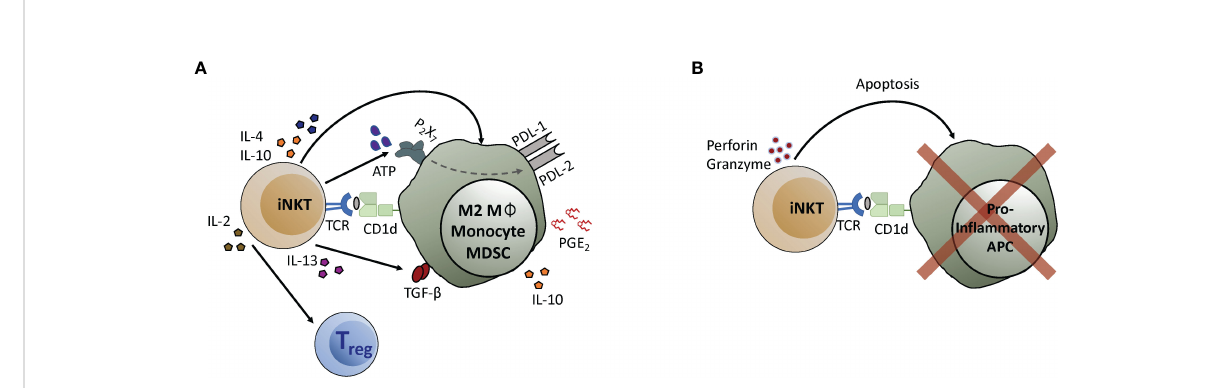
FIGURE 1 iNKT cell anti-in fl ammatory mechanisms. (A) iNKT cells interact with myeloid cell types to initiate the activation of regulatory pathways. Recognition of antigens presented by CD1d molecules expressed by myeloid cells induces iNKT cells to produce cytokines like IL-4, IL-10, or IL-13, that in turn act on the APCs. IL-4 and IL-10 promote macrophage differentiation into an M2 phenotype. IL-13 promotes monocyte differentiation into APCs that express suppressive cytokines such as IL-10 and TGF- b . Secretion of ATP by iNKT cells leads to upregulation of the checkpoint inhibitors PD-L1 and PD-L2, and iNKT interaction with monocytes induces secretion of PGE 2 by mechanisms that have not yet been determined. Additionally, IL-2 produced by iNKT cells helps to drive the expansion of T regs . (B) iNKT cells can lyse pro-in fl ammatory APCs, leading to reduced T cell activation. In this case, recognition of antigens presented by CD1d molecules activates iNKT cells to release cytolytic granules that induce apoptosis of pro-in fl ammatory